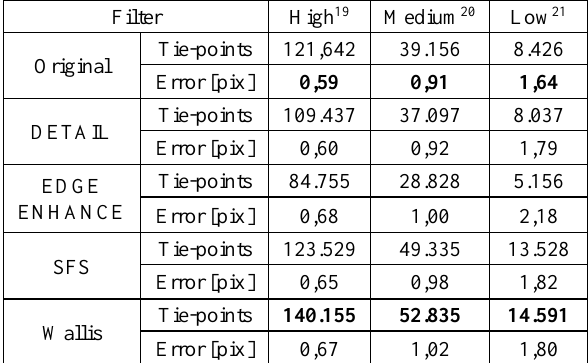
Table 6. Numbers of tie-points and reprojection error at different quality levels of alignment for each of the employed image-enhancement